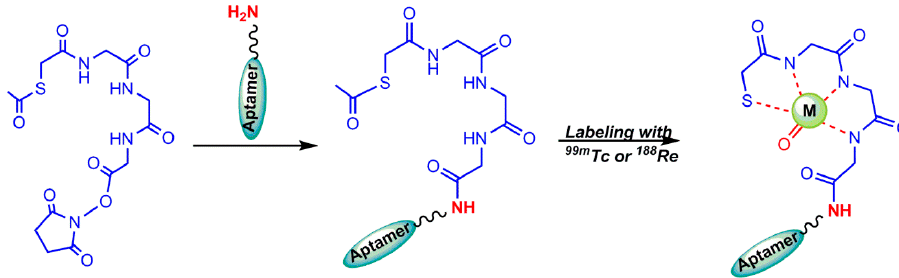
Figure 4. Conjugation of the NHS–MAG 3 chelator to an amine ‐ derivatized aptamer, and radiolabeling.